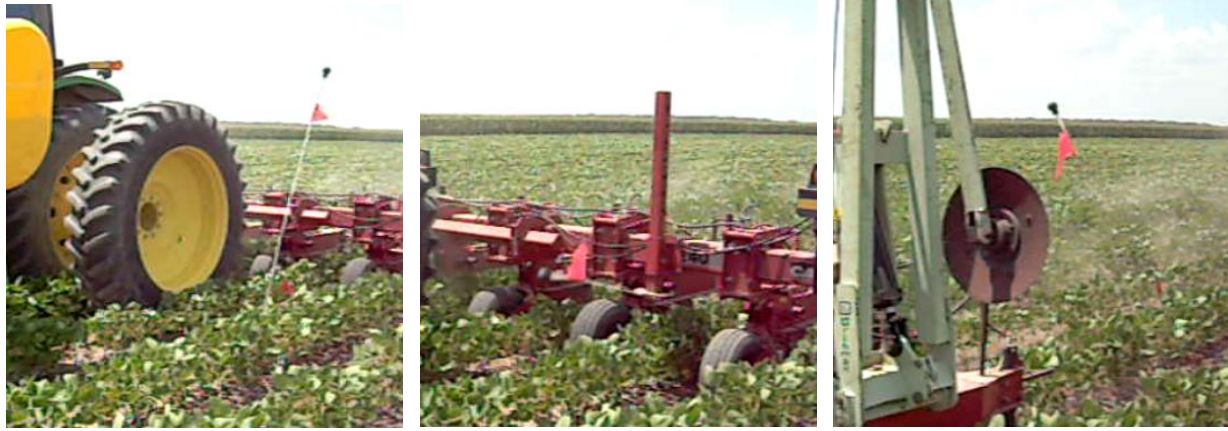
Figure 3. Encounter between radio/antenna mount and cultivator implement before ( Left ), during ( Center ), and after ( Right ) passage of the